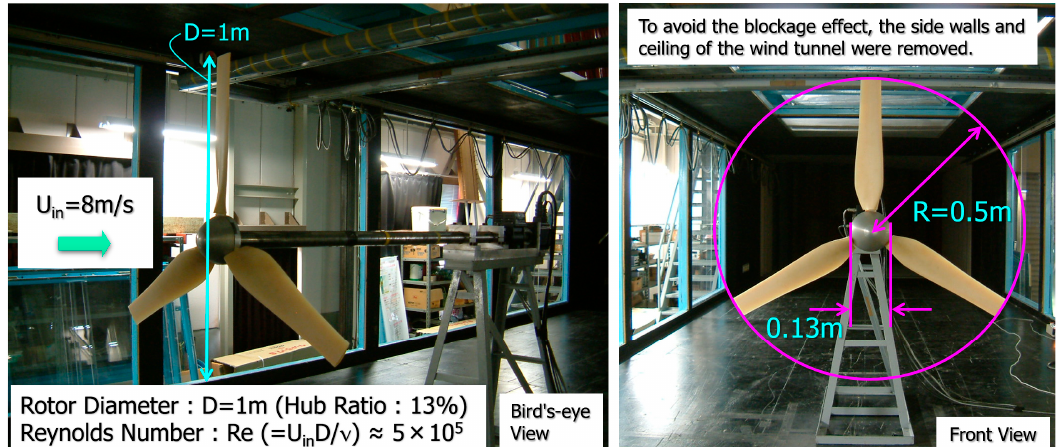
Figure 3. Wind-turbine scale model used in this study.